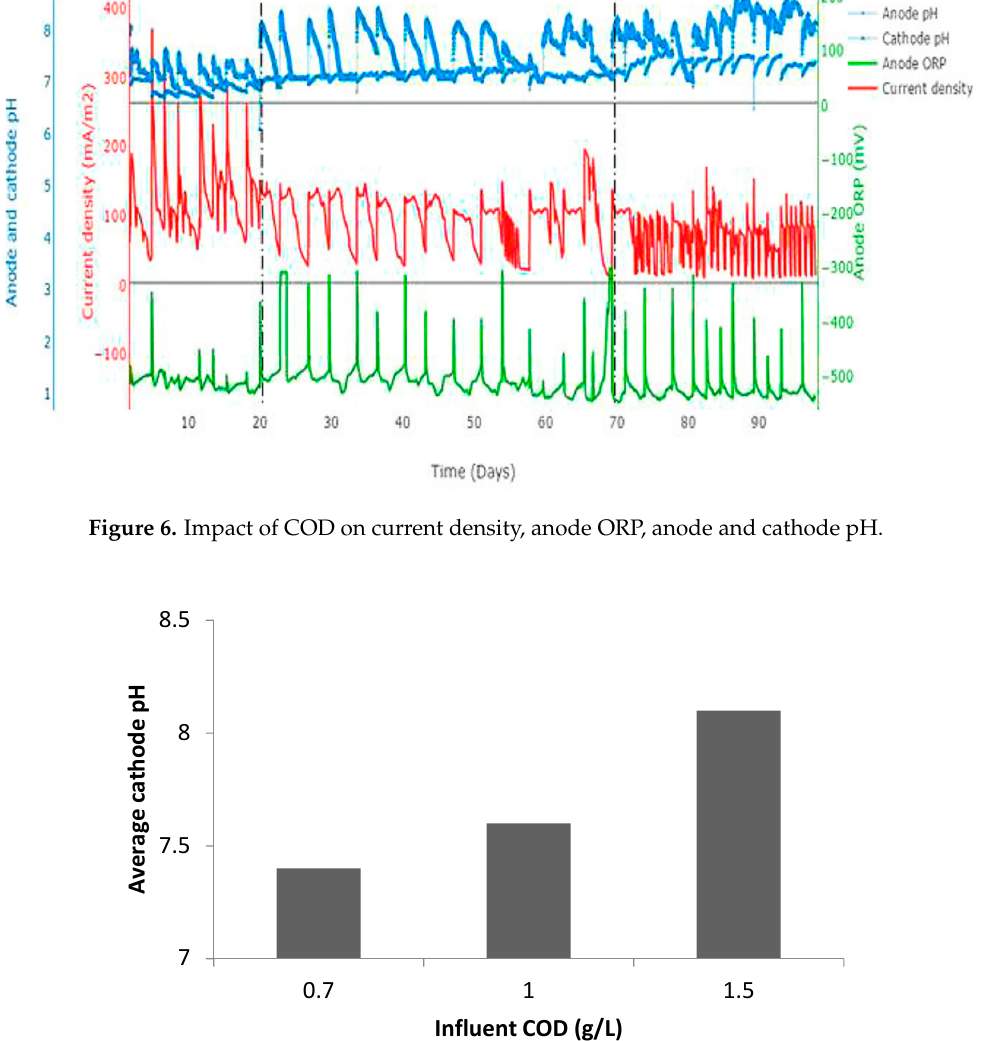
Figure 7. Impact of COD concentrations on cathode pH.